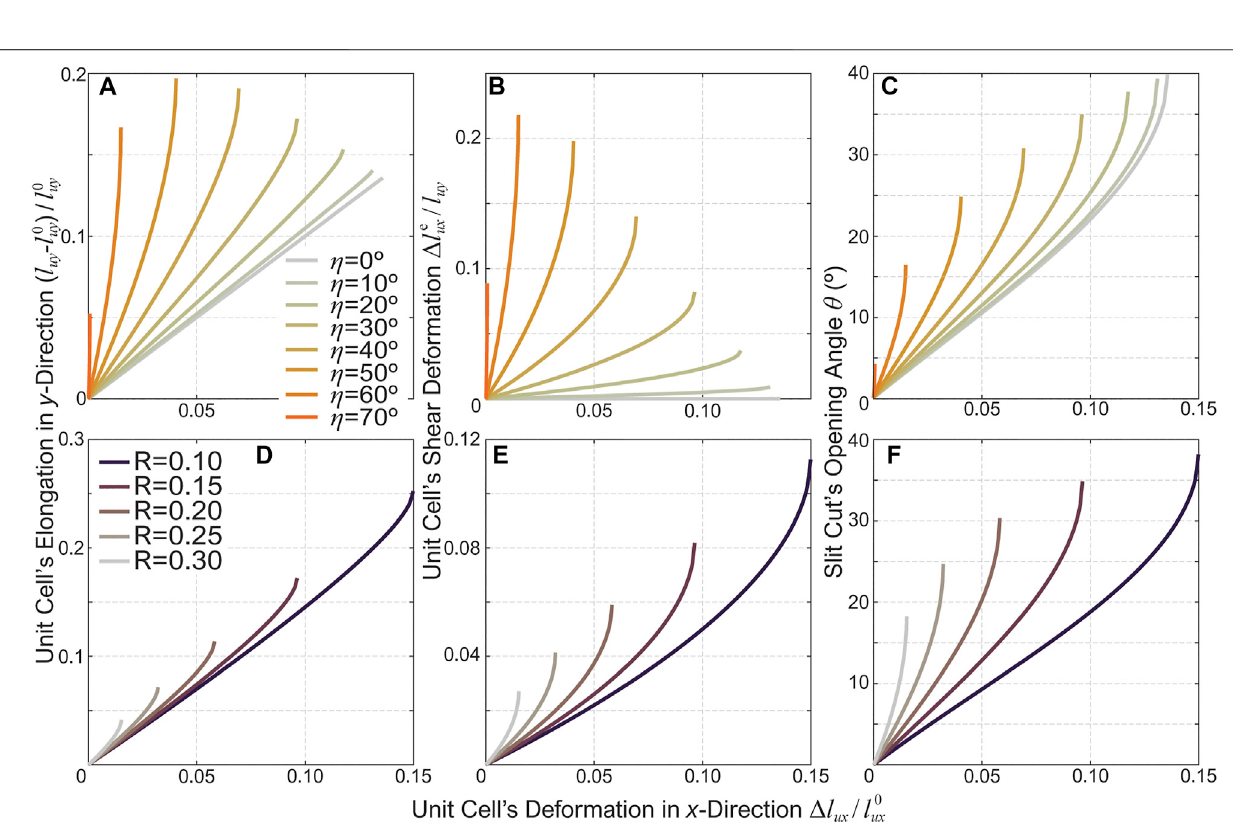
Frontiers in Robotics and AI |